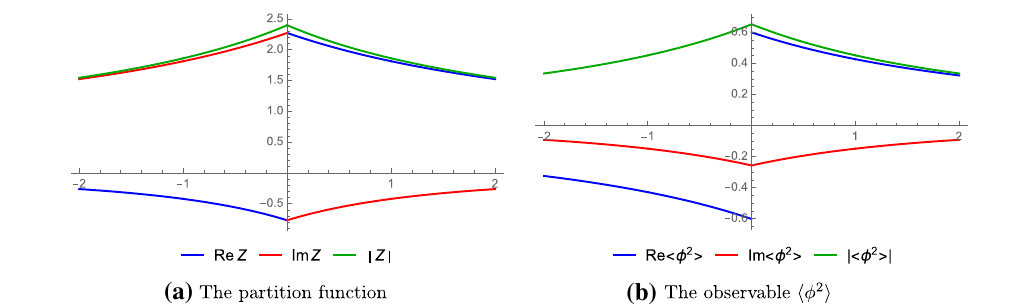
Fig. 8 The partition function Z ≡ Z ( a , b , c , d , h ) and the observable (cid:2) φ 2 (cid:3) as a function of a for the fixed parameters { b = 1 , c = 1 , d = 0 , h = 0 } . The blue curve represents the real part, the red curve rep- resents the imaginary part, and the green curve represents the absolute Fig. 9 Change in the structure of thimbles as the parameter a crosses the phase boundary a = a c = 0. In both the figures, the green solid curves represent the thimbles, red dashed curves represent the anti-thimbles, and the grey solid curves represent the ghosts. The shaded regions represent the regions where Re ( S ) ≥ 0. We see that there is a drastic change in the underlying thimble structure as the system passes through a phase